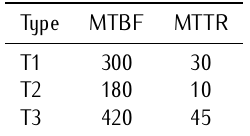
Table 1. MTBF and MTTR in min for the tree types of machines